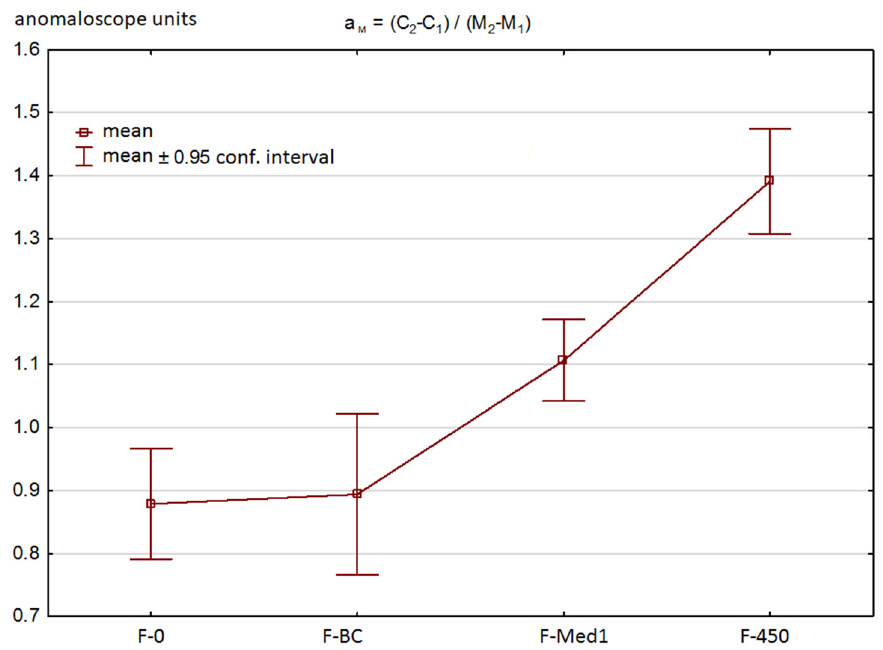
Figure 3. Values of the slope (a M ) for C = fn(M) matching (mean/mean standard error). As the amount of blue light is reduced by a filter, the value of the slope ratio increases. This reflects the reduced impression of perceived brightness of blue when a filter is introduced. Except for the F-0 vs. F-BC comparison, other differences had high statistical significance ( p < 0.001) in the Wilcoxon test.